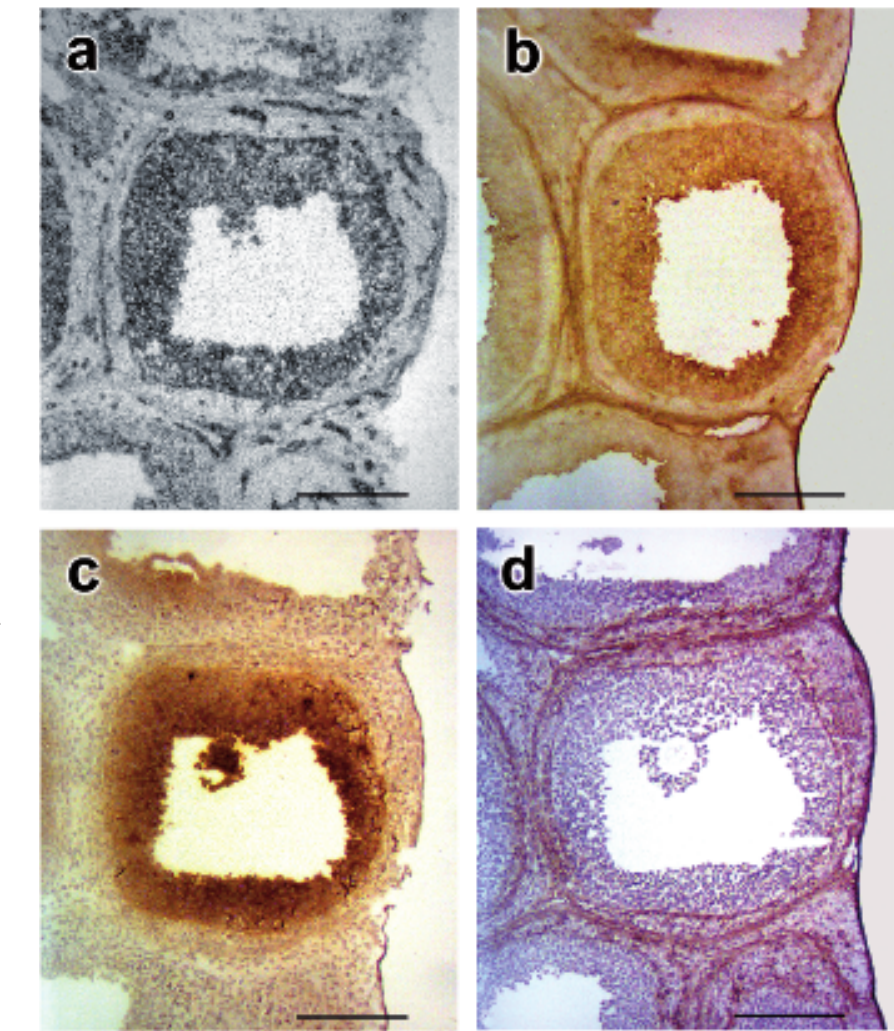
Figure 2 Co-localisation of aHSPG and of serpins in rat ovarian follicles Serial cryosections stained for aHSPG by 125 I-AT-binding revealed by autoradi- ography (a), and for AT (b), PN-1 (c) and PAI-1 (d) by immuno- histochemistry. Gona- dotrophin-induced cycle, preovulatory follicle 6h after ovulation induction. Shortly before ovula- tion, aHSPGs, AT and PN-1 labelling is maximal showing that AT and PN-1 are exactly co-localised with aHSPGs on the whole surface of the GC layer (a, b, c), while PAI-1 is strictly restricted to base- ment membranes